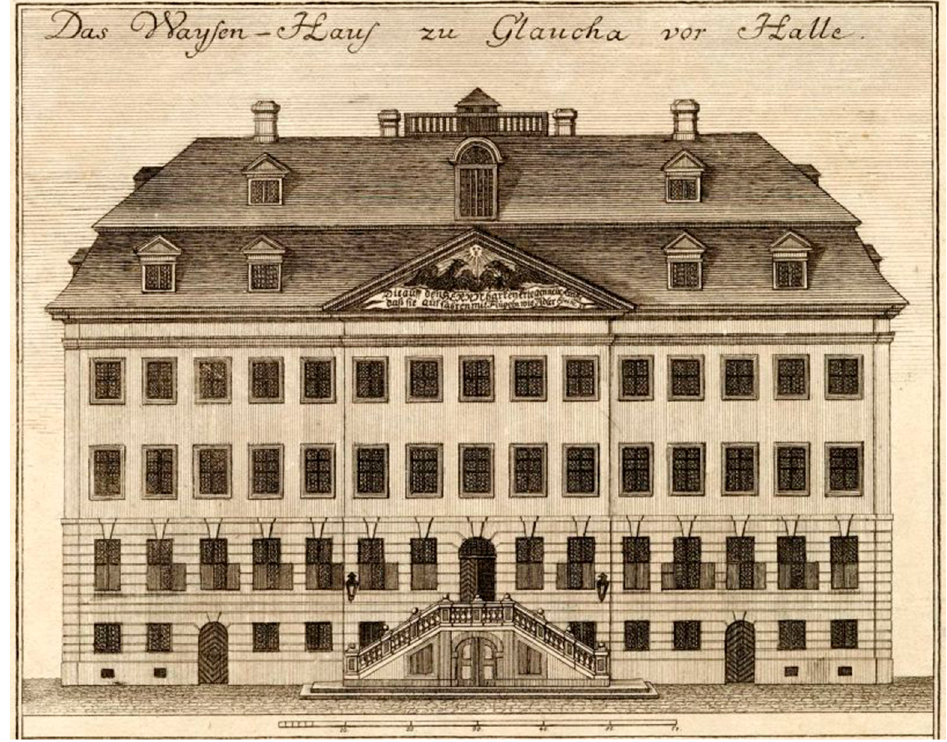
Figure 1. Engraving of the main orphan house of the Francke Foundations (Grundler 1749). Gottfried August Gründler, The Francke Foundations in Halle . 1749. Public Domain.